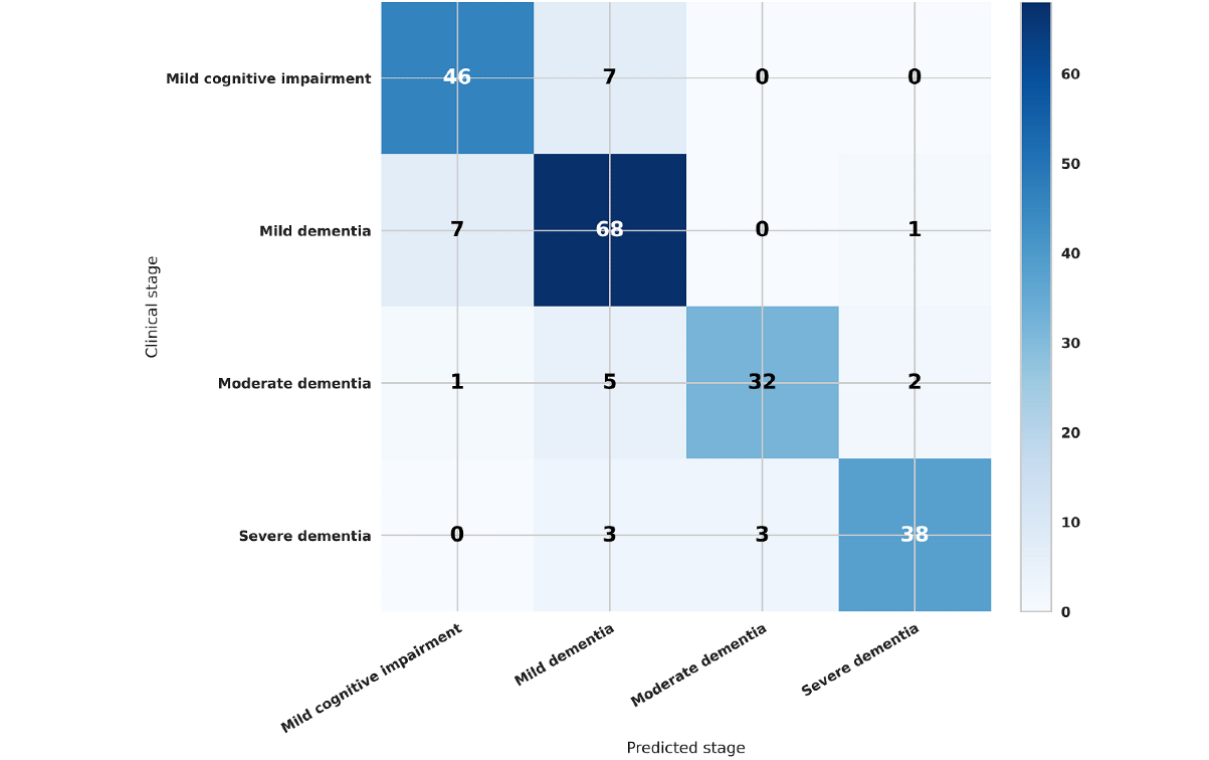
Figure 2. Confusion matrix of the trained model. Each row of the matrix represents the instances of actual dementia stage while each column represents the instances of predicted dementia stage. Counts are colored from the highest cell (darker) to the lowest (lighter). The top-left to bottom-right diagonal cells count correctly predicted dementia stages.